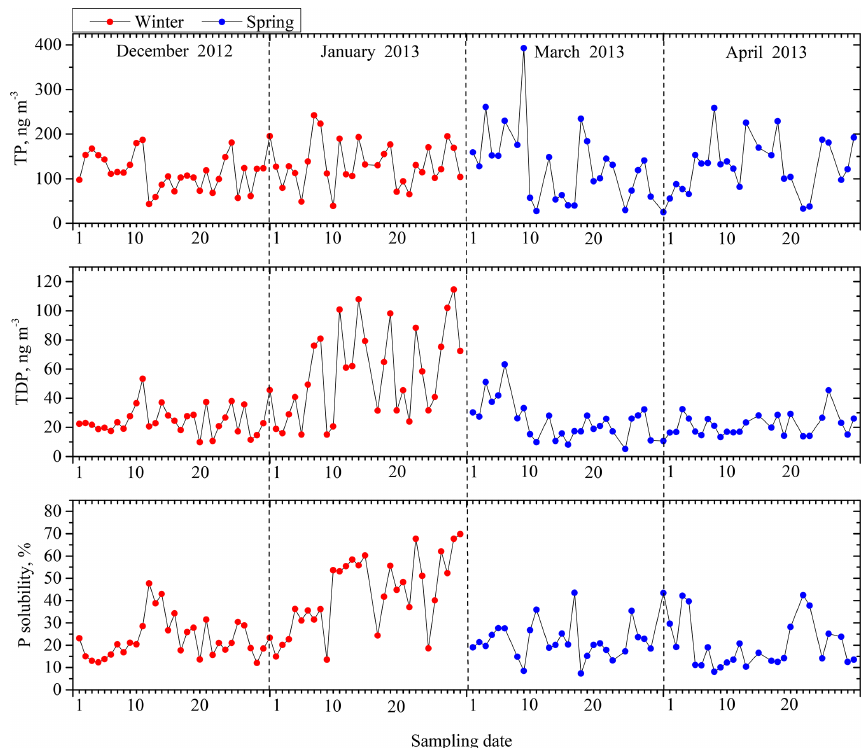
Figure 1. Time series of total and dissolved P concentrations (TP and TDP) and P